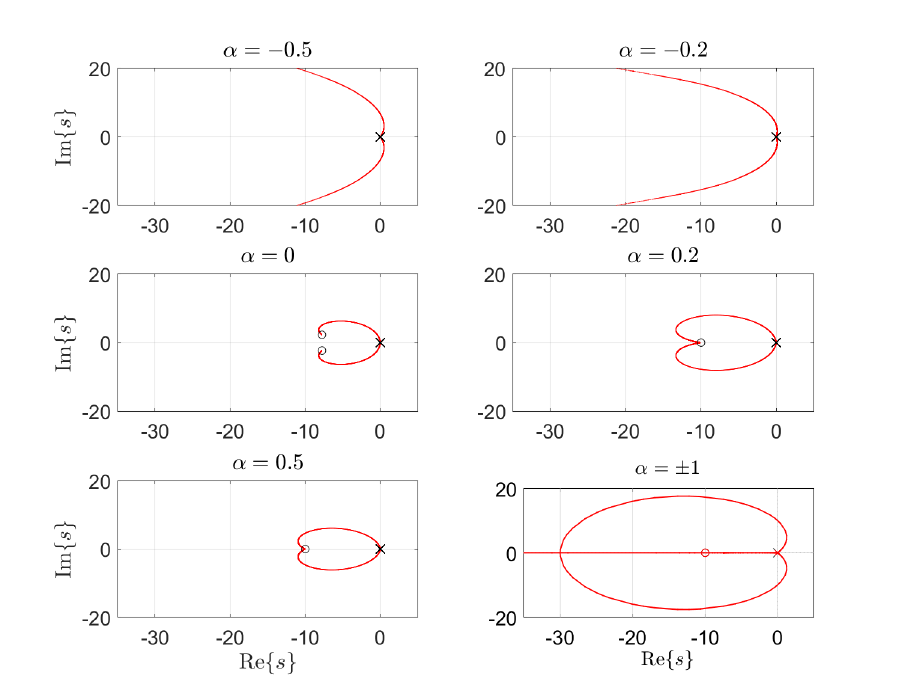
Figure 2. The root locus for various values of α